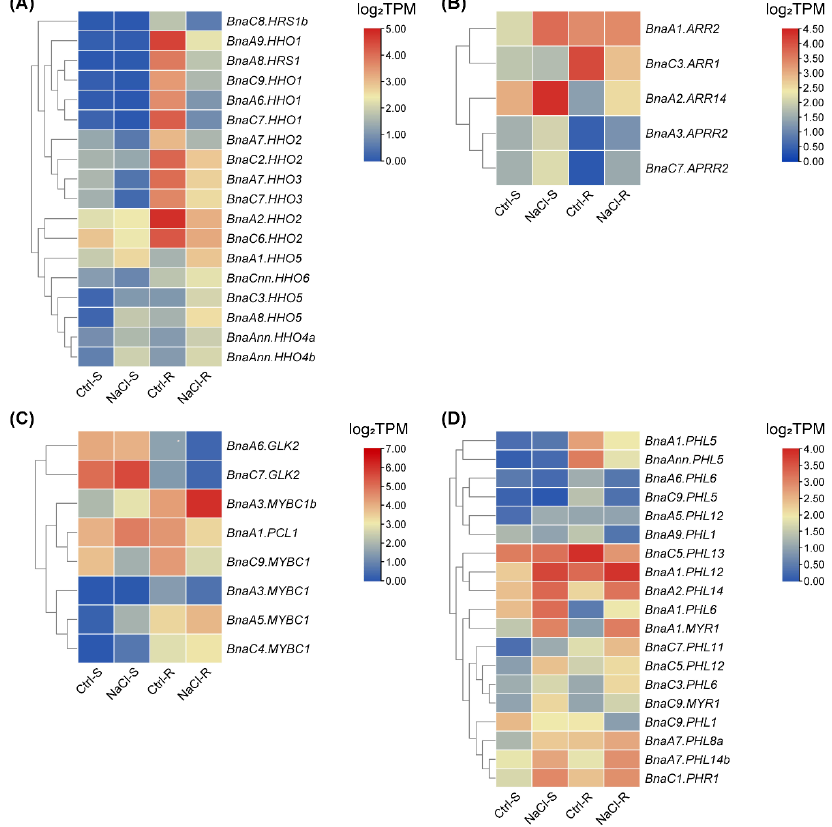
Figure 13. Expression profiles of BnaNIGT1/HRS1/HHOs ( A ), BnaARRs ( B ), BnaGLKs ( C ), and BnaPHLs ( D ) in the shoots/S and roots/R under salt stress conditions. Ctrl, control, NaCl-free; NaCl, +NaCl, 200 mM. In the heat maps, the expression levels are normalized by log 2 (TPM). TPM, transcripts per million (reads). The color scales represent relative expression levels from high (red color) to low (blue color).